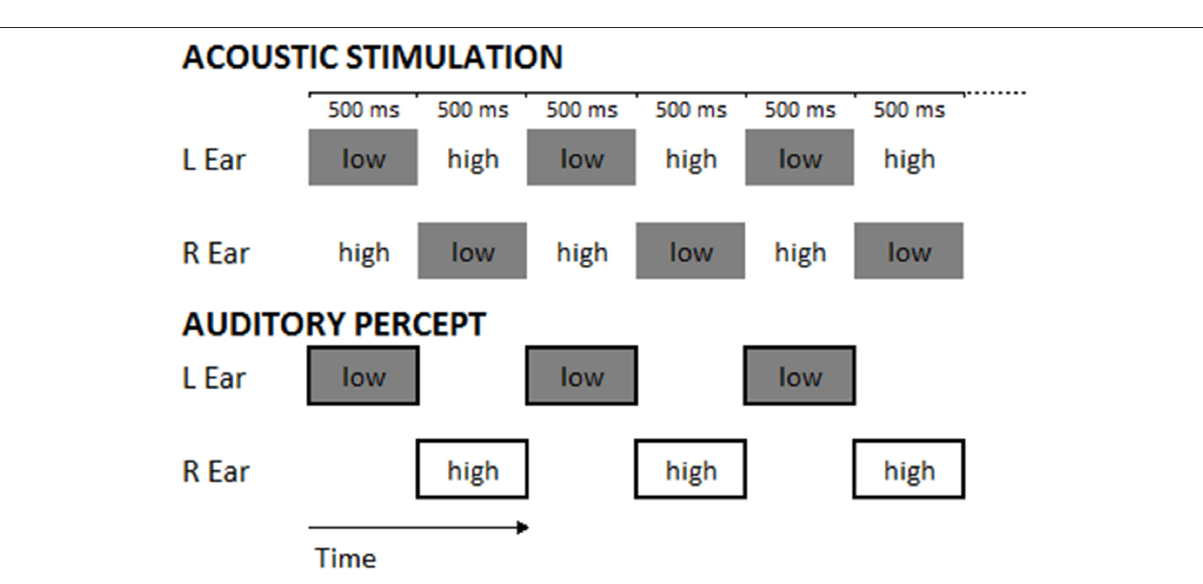
FIGURE 2 | The upper panel represents the stimuli constituting the experimental trials (numbers indicate tone frequencies in Hz; in each trial 20 dichotic stimuli were presented). The lower panel represents the typical perception of a participant during the Deutsch’s illusion. Low and High refer to the pitch of tones (400-Hz tone: low-pitched tone; 800-Hz tone: high-pitched